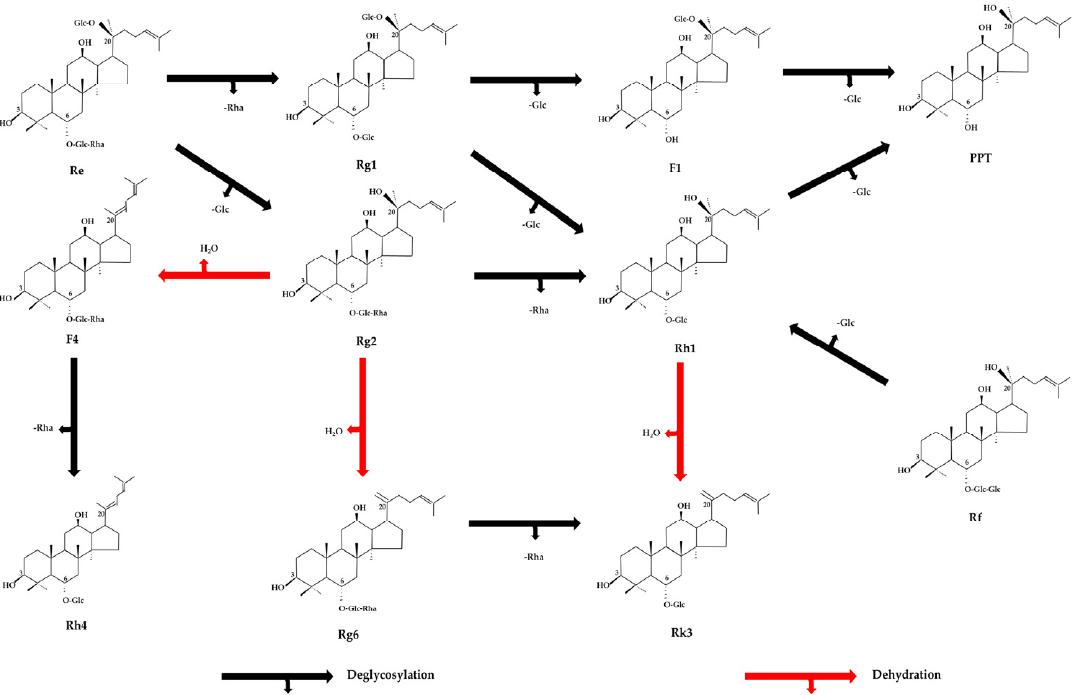
Figure 5. Transformation trends of PPT-type ginsenosides.